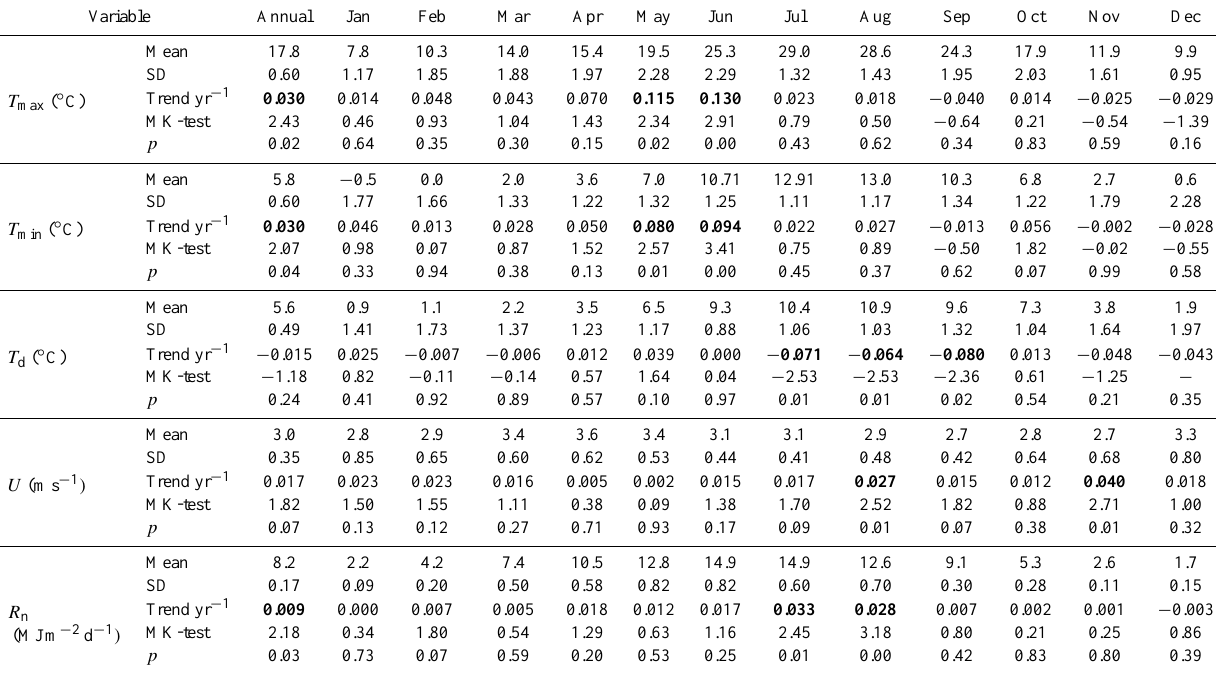
Table 1. Descriptive and conditional Mann-Kendall test (MK-test) statistics for variables Maximum Temperature ( T max ) , Minimum Tem- perature ( T min ) , Dew Point ( T d ) , Wind Speed ( U ), and Net Radiation ( R n ) in stations in the Duero Basin for the period 1980–2009. The numbers in bold indicate significant trends at ≥ 95%